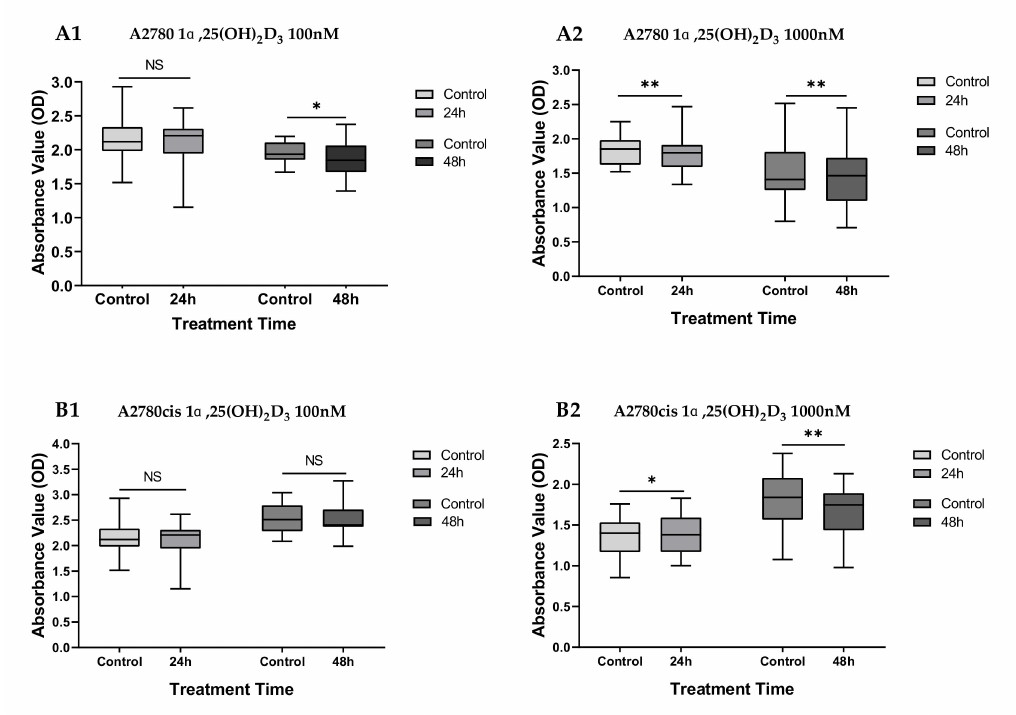
Figure 6. E ff ects of 1 α ,25(OH) 2 D 3 treatment on cell proliferation in A2780 and A2780cis cell lines: